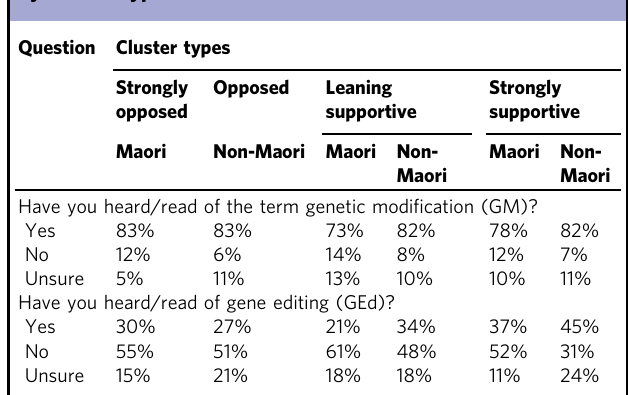
Table 3 Percent of respondents citing familiarity of GM/GEd by cluster